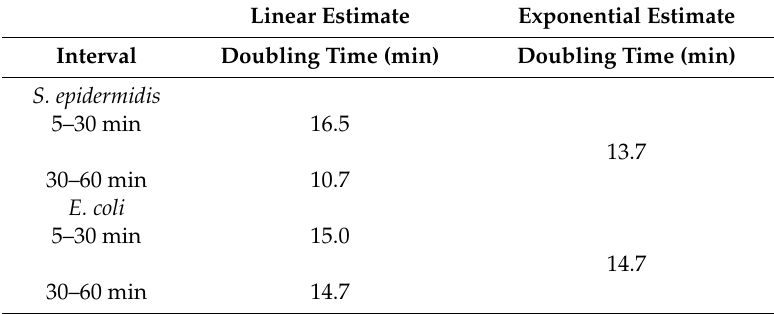
Table 3. Estimates of the signal doubling time of PI (red) fluorescence emission in two assays of Product “B”.